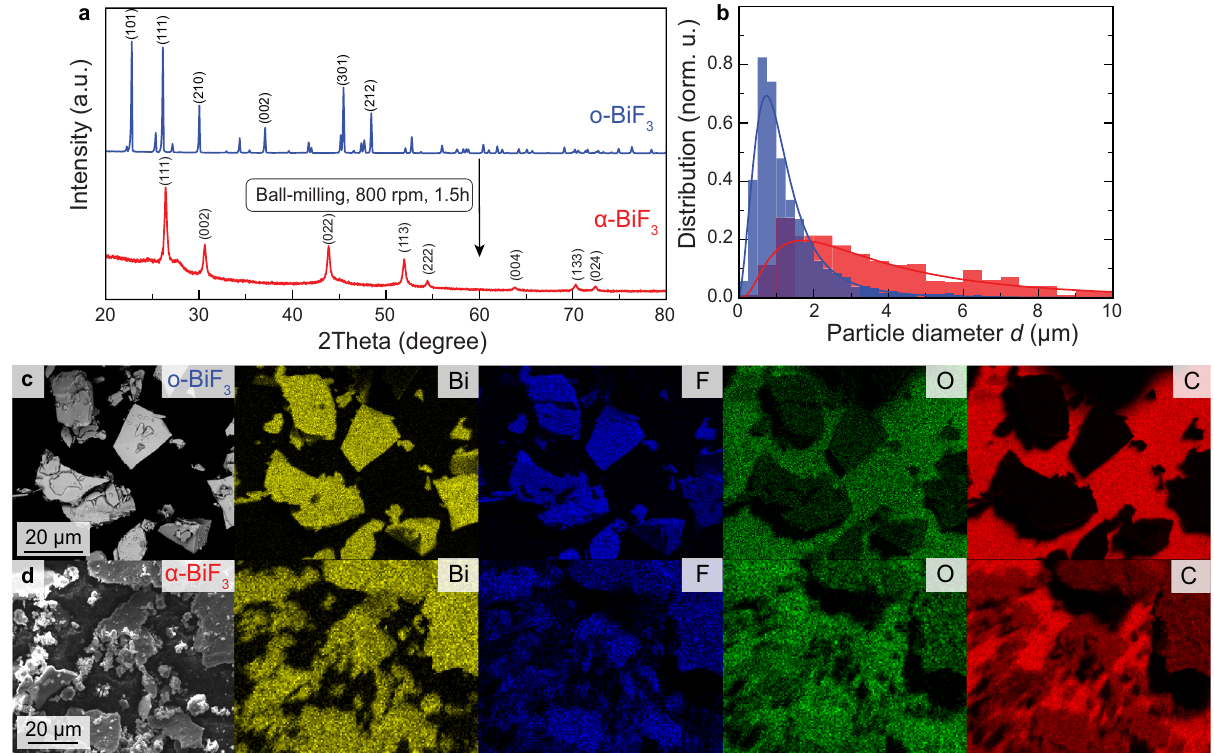
Fig. 3 Characterization of BiF 3 before and after ball milling. a Powder XRD patterns, ( b ) the particle size distributions (see Supplementary Figs. 11, 12 and Supplementary Tables 1, 2 for fi tting details), and ( c , d ) SEM/EDX images of BiF 3 before ( c ) and after ball-milling ( d